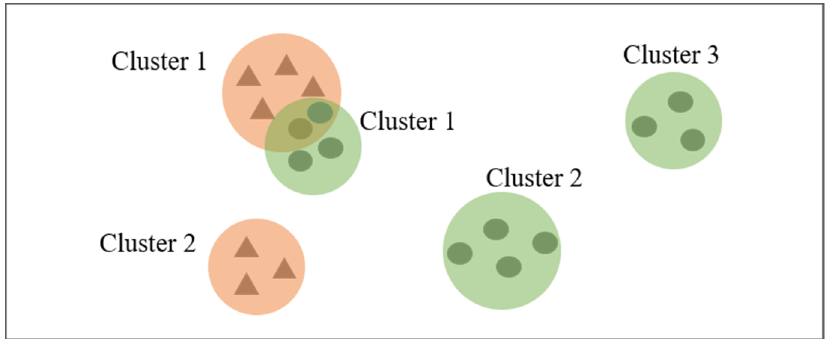
Figure 3. The clustering results of two datasets.